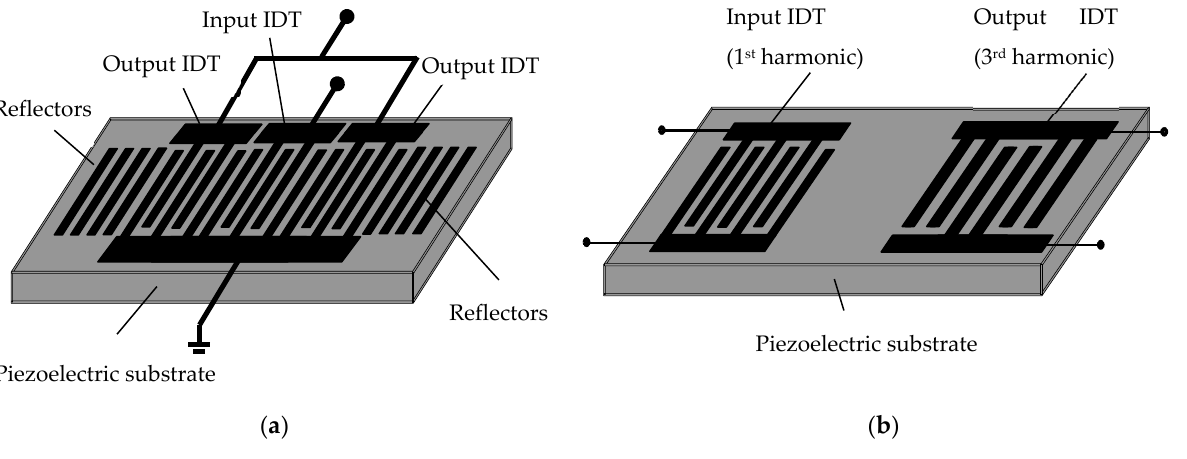
Figure 1. SAW devices: ( a ) resonator filter; ( b ) delay line.